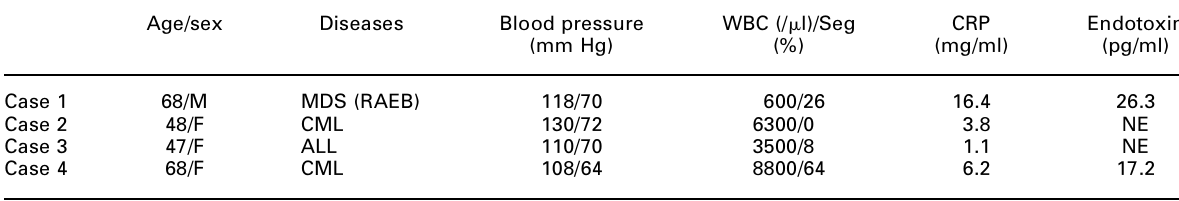
Table 1. Characteristics of patients with sepsis Age/sex Diseases